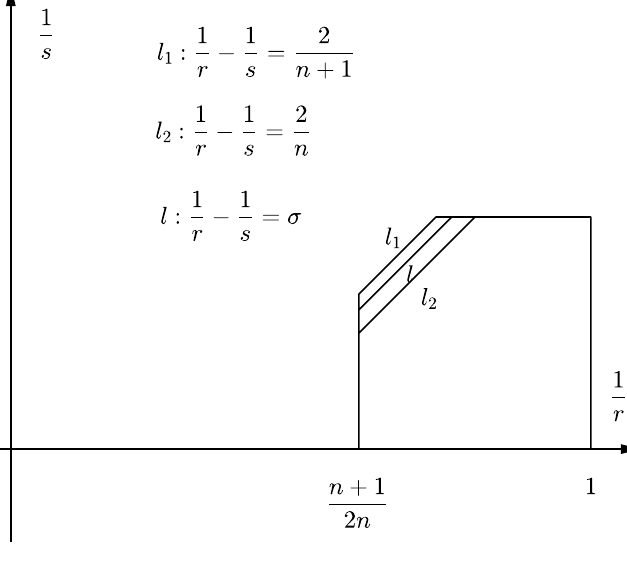
Fig. 1. Exponents for the resolvent estimate in Theorem